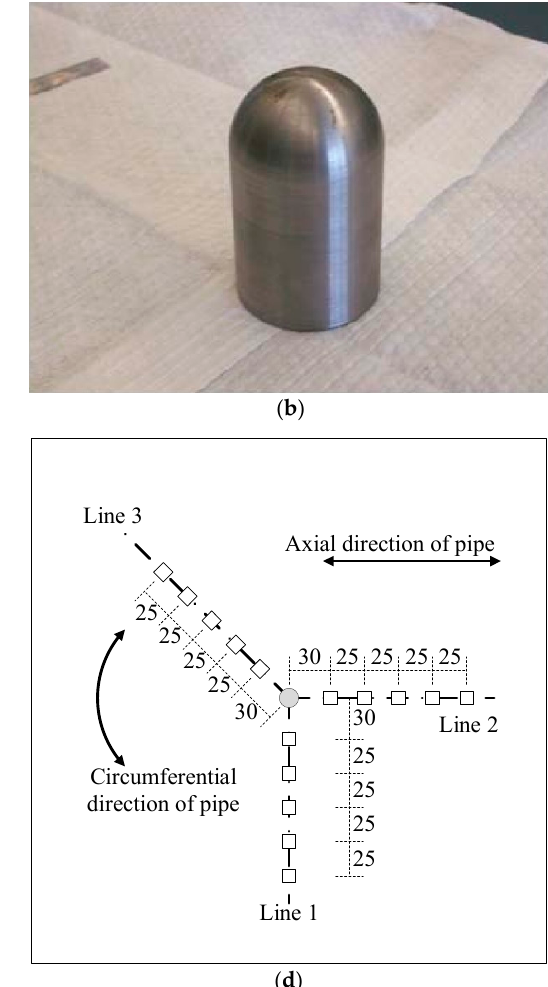
Strain Figure 2. Engineering strain–stress curve of pipe for testing. During the test, an internal pressure of 4.83 MPa was applied to the pipe through a static hydraulic pump and a hydraulic press connected to a semi-spherical indenter with a curvature radius of 25 mm (Figure 3a). This was used to apply an external load on the